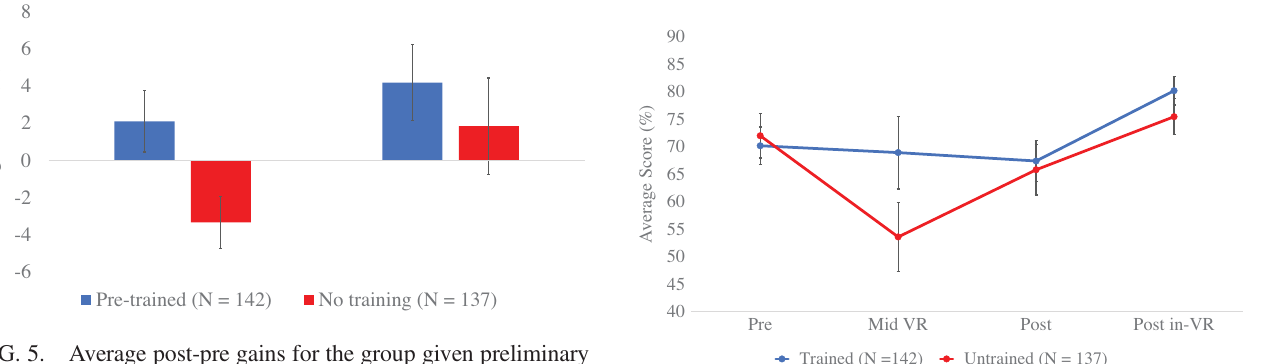
FIG. 5. Average post-pre gains for the group given preliminary training, and the group that did not, separated by those reporting high gaming experience (gamer) and low gaming experience (nongamer).